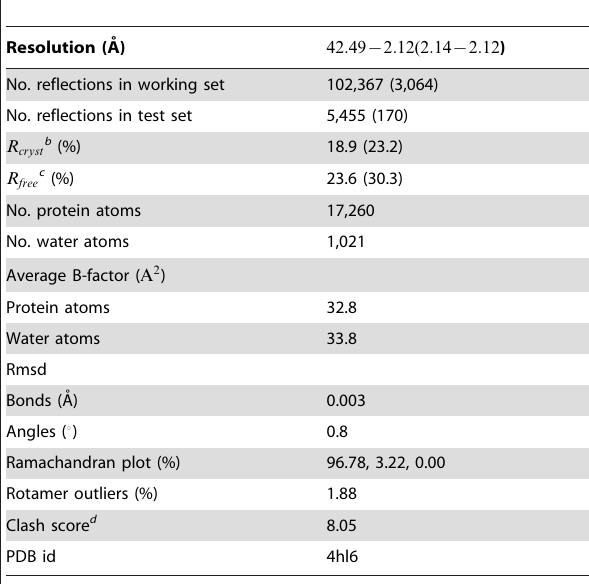
Table 4. Crystallographic refinement statistics for H6YfdE.